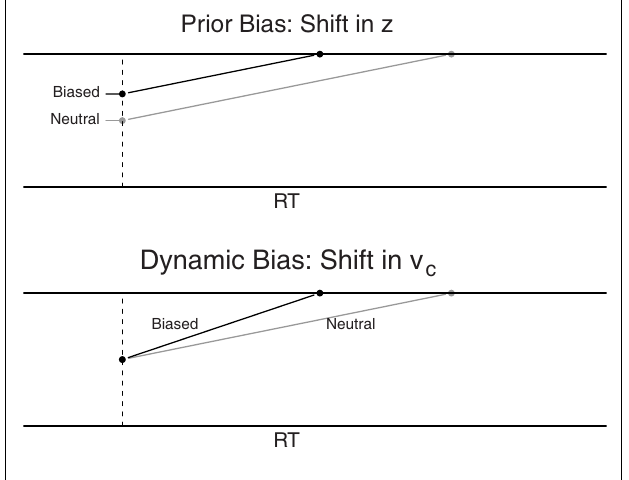
FIGURE 2 | Schematic representation of bias due to a shift in starting point z (top panel) or a shift in drift rate criterion v c (bottom panel). The gray lines represent neutral stimuli for